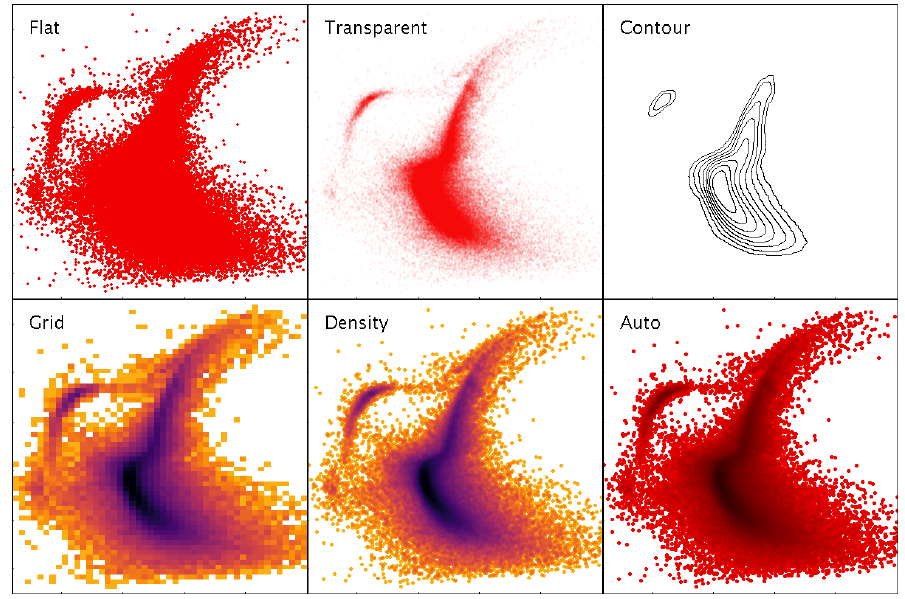
Figure 4. Various representations of a 2-dimensional point cloud available within TOPCAT. Flat simply plots markers at each point, obscuring the density structure. Transparent plots partially transparent markers, giving some indication of overdense regions, however regions over a certain density threshold are saturated. Contour is a somewhat smoothed contour plot. Grid is a 2-d histogram on a grid of fixed size rectangular bins; various options are available for combination within bins including mean, median, min, max etc. Density structure is clear, but resolution is lost and outliers are poorly represented. Density is a hybrid density map/scatter plot with a configurable colour map, showing both high-density structure and individual outliers. Auto is a standard profile of the hybrid map used by default, with a fixed colour map scaling that fades from a dataset’s chosen colour to black; multiple overplotted datasets can be distinguished by using different base colours. Data represent a V vs. B - V colour-magnitude diagram of 139,000 stars from the globular cluster ω Centauri